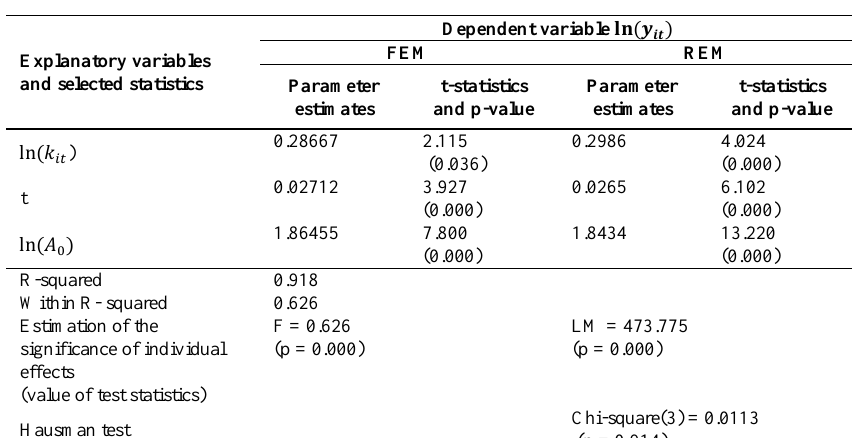
Table 6. Results of labour productivity model estimation